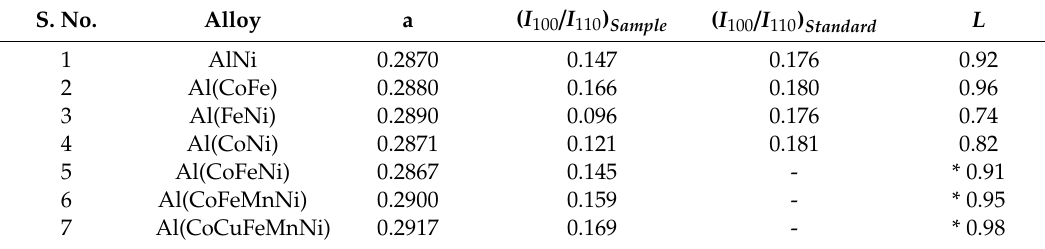
Table1. Latticeparameter(a)andlong-rangeorderparameters( L )calculatedfromX-raydi ff ractiondata. S.